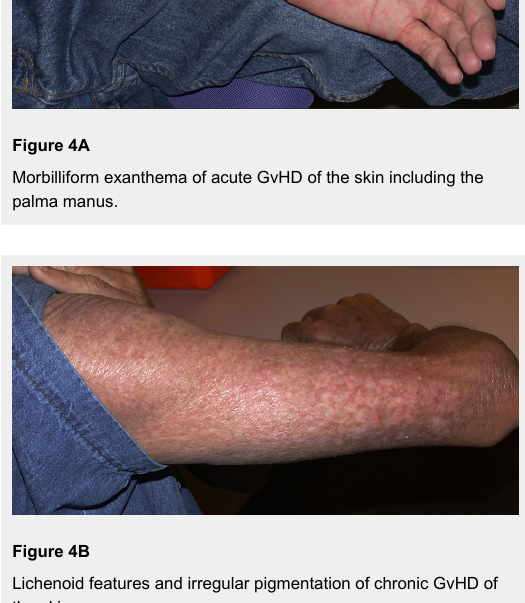
Lichenoid features and irregular pigmentation of chronic GvHD of the